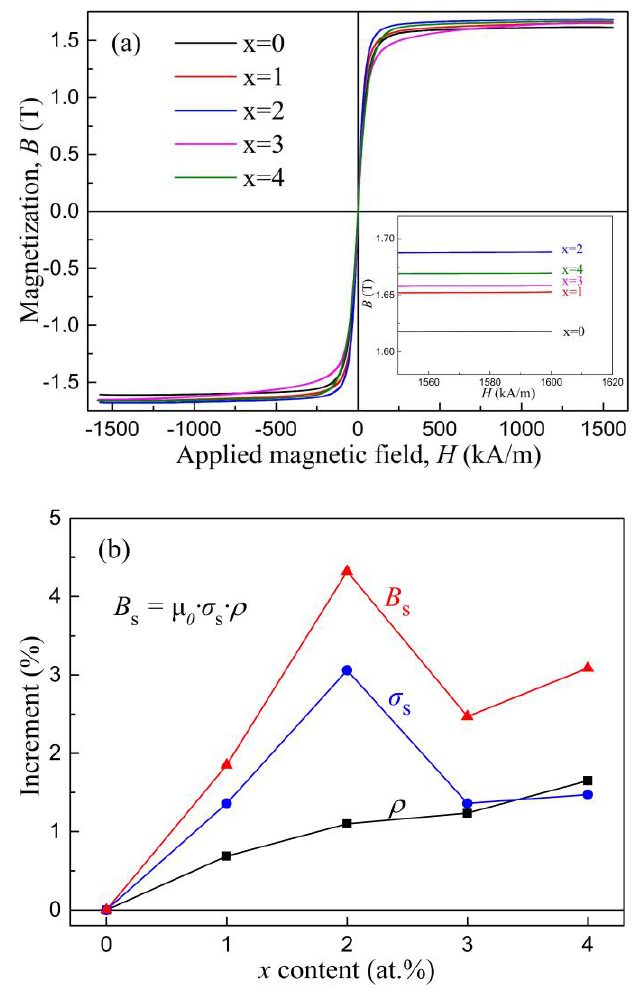
Figure 9. ( a ) Hysteresis loops of the Fe 80+x Si 5 − x B 15 ( x = 0 – 4) amorphous ribbons. The insert shows the enlarged partial hysteresis curves of the samples. ( b ) The ρ , σ s , and B s values as functions of Fe content.